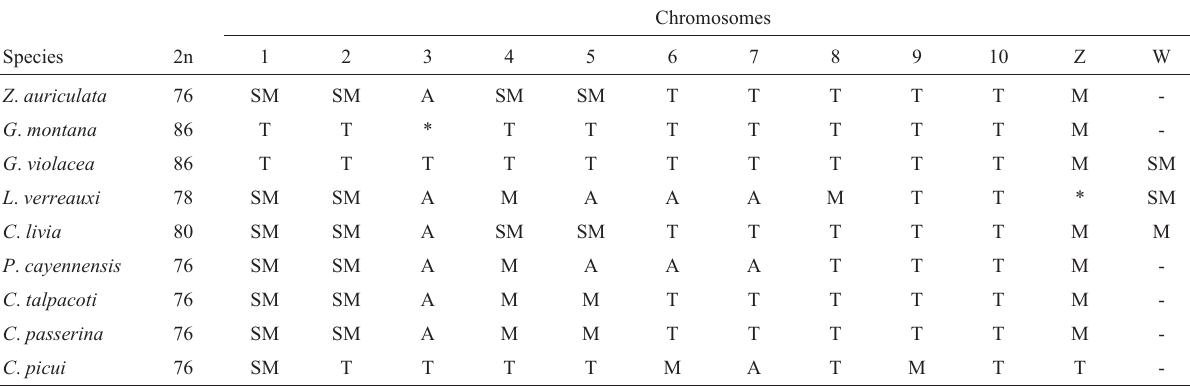
Table 2 - Diploid number and chromosomal morphology of the nine Columbidae species included in this study.